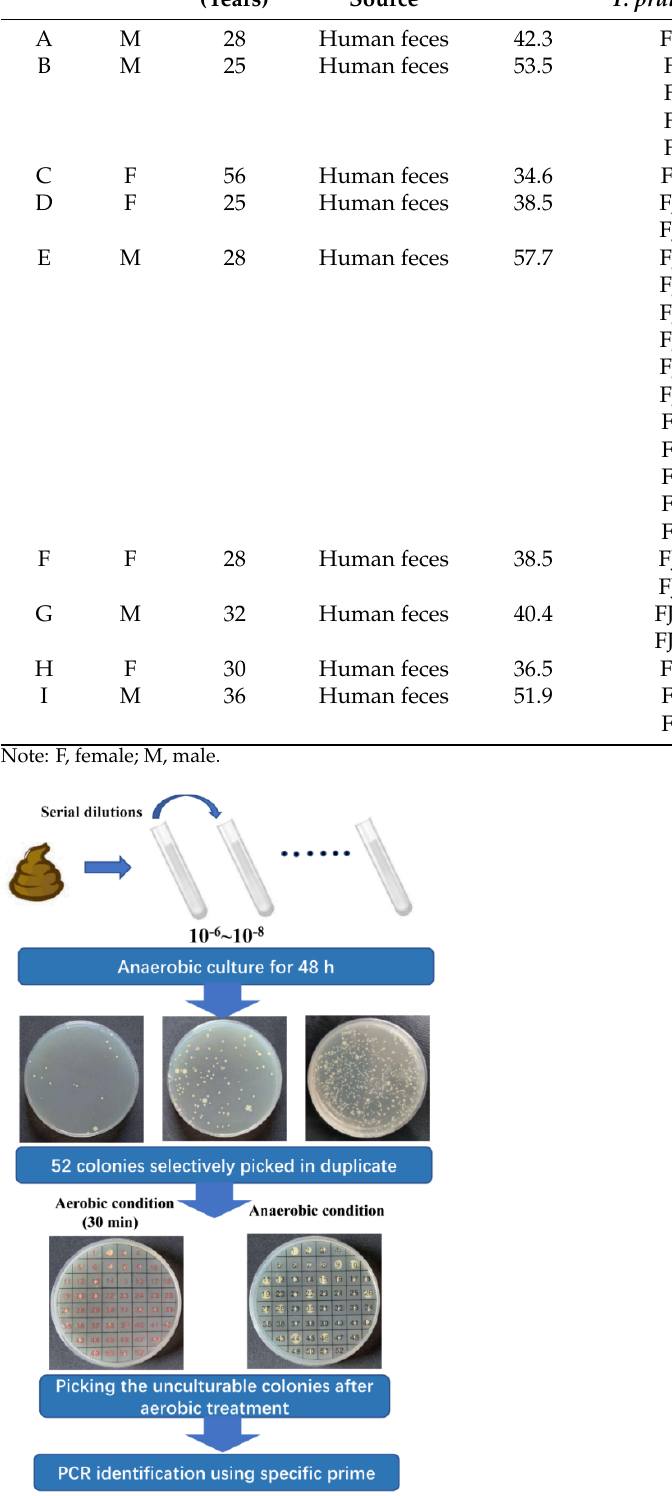
Table 1. Information about fecal samples and newly identified F. prausnitzii strains.